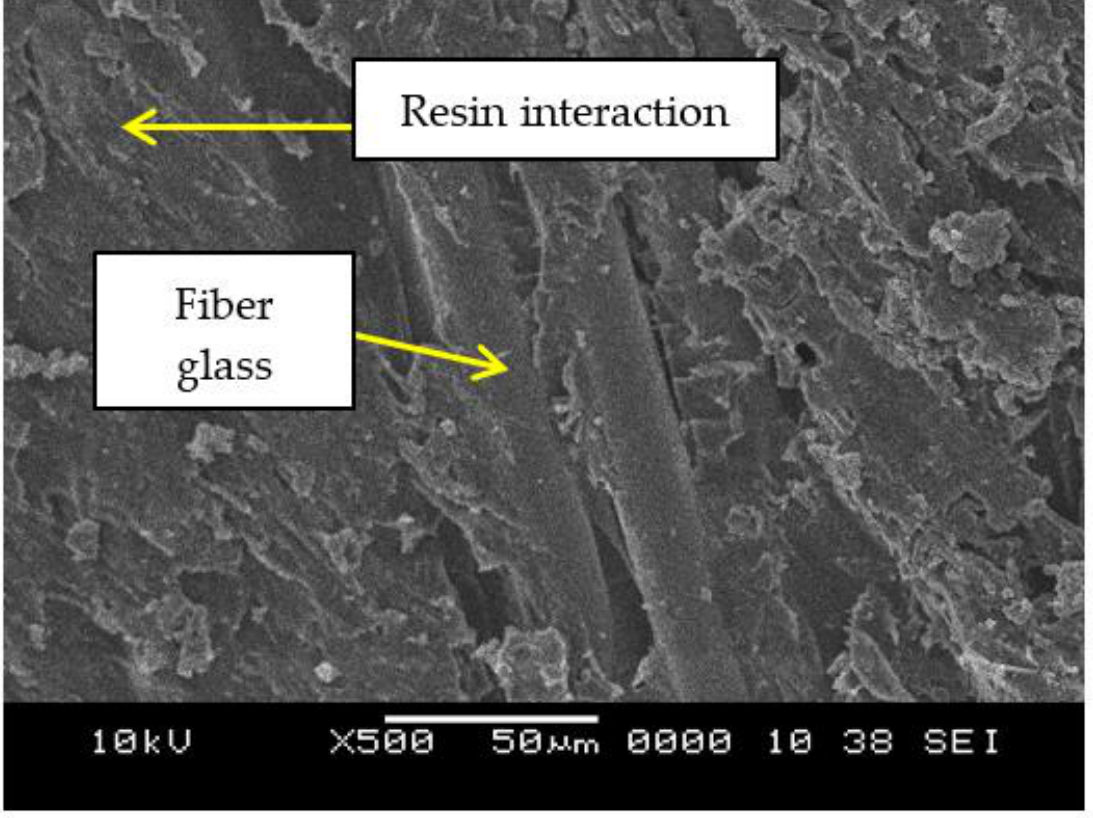
Figure 10. SEM images of control sample GRE pipe without any geopolymer filler.